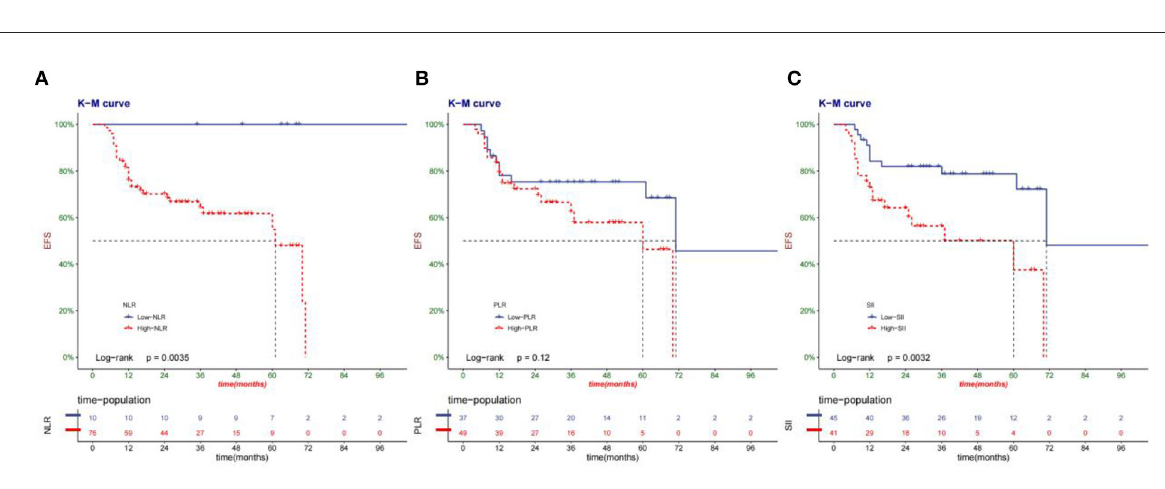
86 included patients, NLR ≥ 0.80, PLR ≥ 97.9, SII ≥ 565